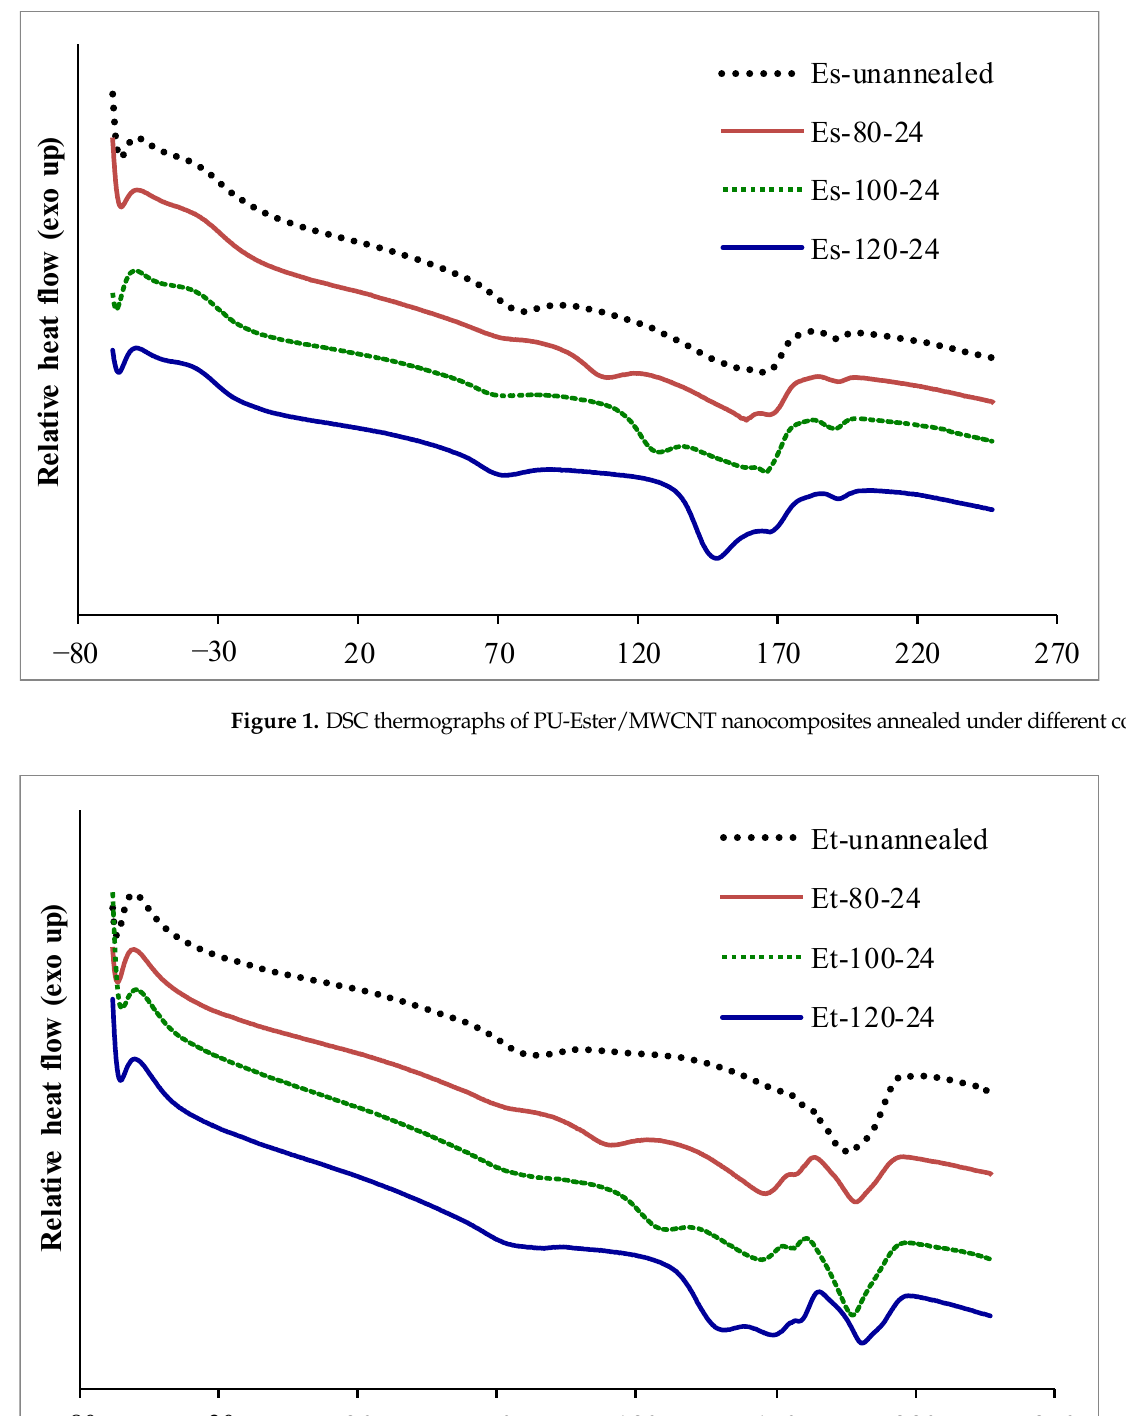
Figure 2 . DSC thermographs of PU - Ether / MMCNTs nanocomposites . Figure 2. DSC thermographs of PU-Ether/MMCNTs Table 1 . DSC analysis of PU - Ester / MWCNT nanocomposites and PU - Ether / MWCNT